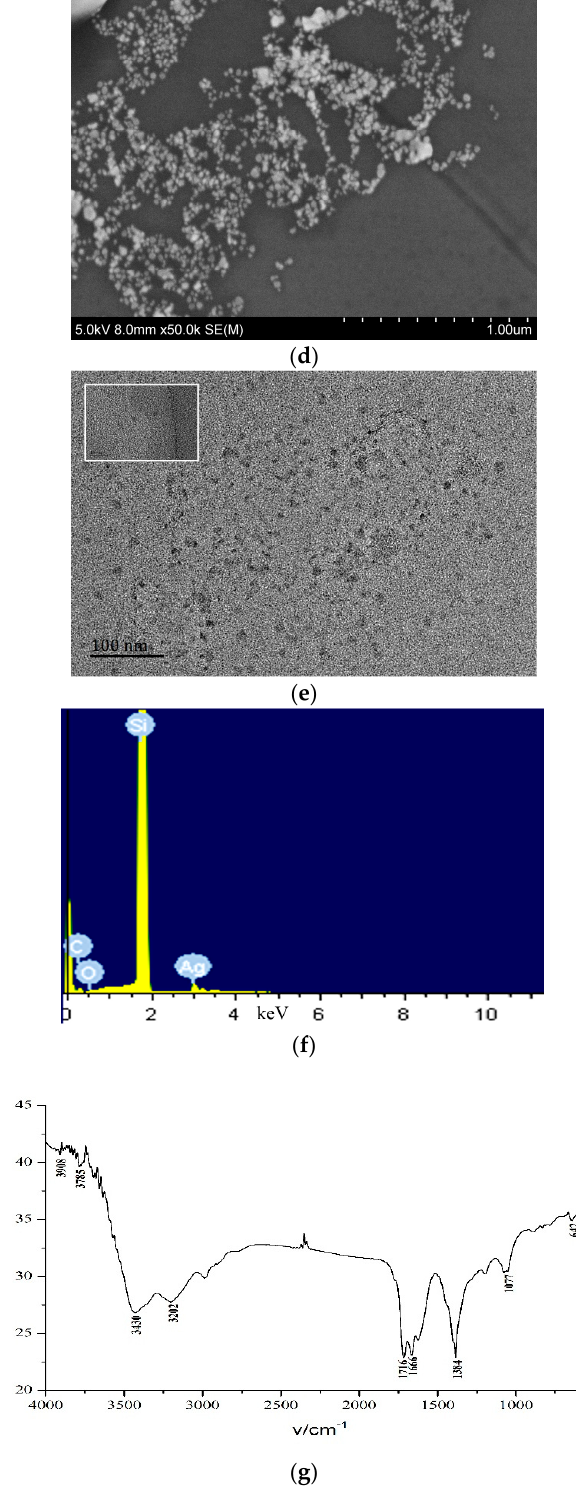
Figure 3. Scanning electron microscopy (SEM), transmission electron microscopy (TEM), energy spectra and infrared spectra. ( a ) SEM image of AgNPs; ( b ) TEM image of AgNPs (the inserted Figure was the surface plasmon resonance absorption spectrum of AgNPs); ( c ) 0.026 μ mol/L Apt + 6.67 μ g/L CD NAg2 + 0.08 mmol/L H 2 O 2 + 0.025 mmol/L DBD + pH 3.6 HAc-NaAc + 0.11 mmol/L AgNPs; ( d ) SEM of c + 0.5 µ g/L ACT; ( e ) TEM of CD NAg2 ; ( f ) energy spectra of CD NAg2 ; and ( g ) infrared spectra (IR) image of CD NAg2